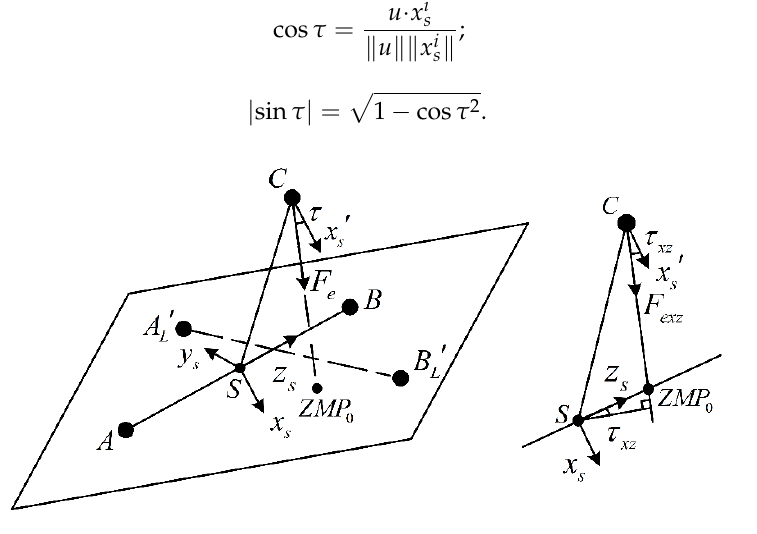
Figure 9. Angle between 𝐹 𝑒 and 𝑥 𝑠 .